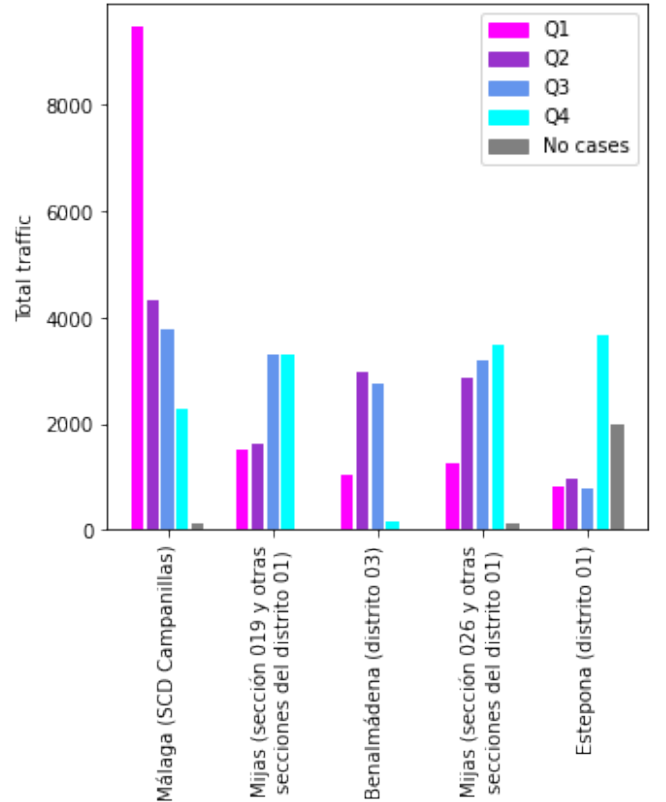
Figure 9. Traffic profiles for anomalous cells of